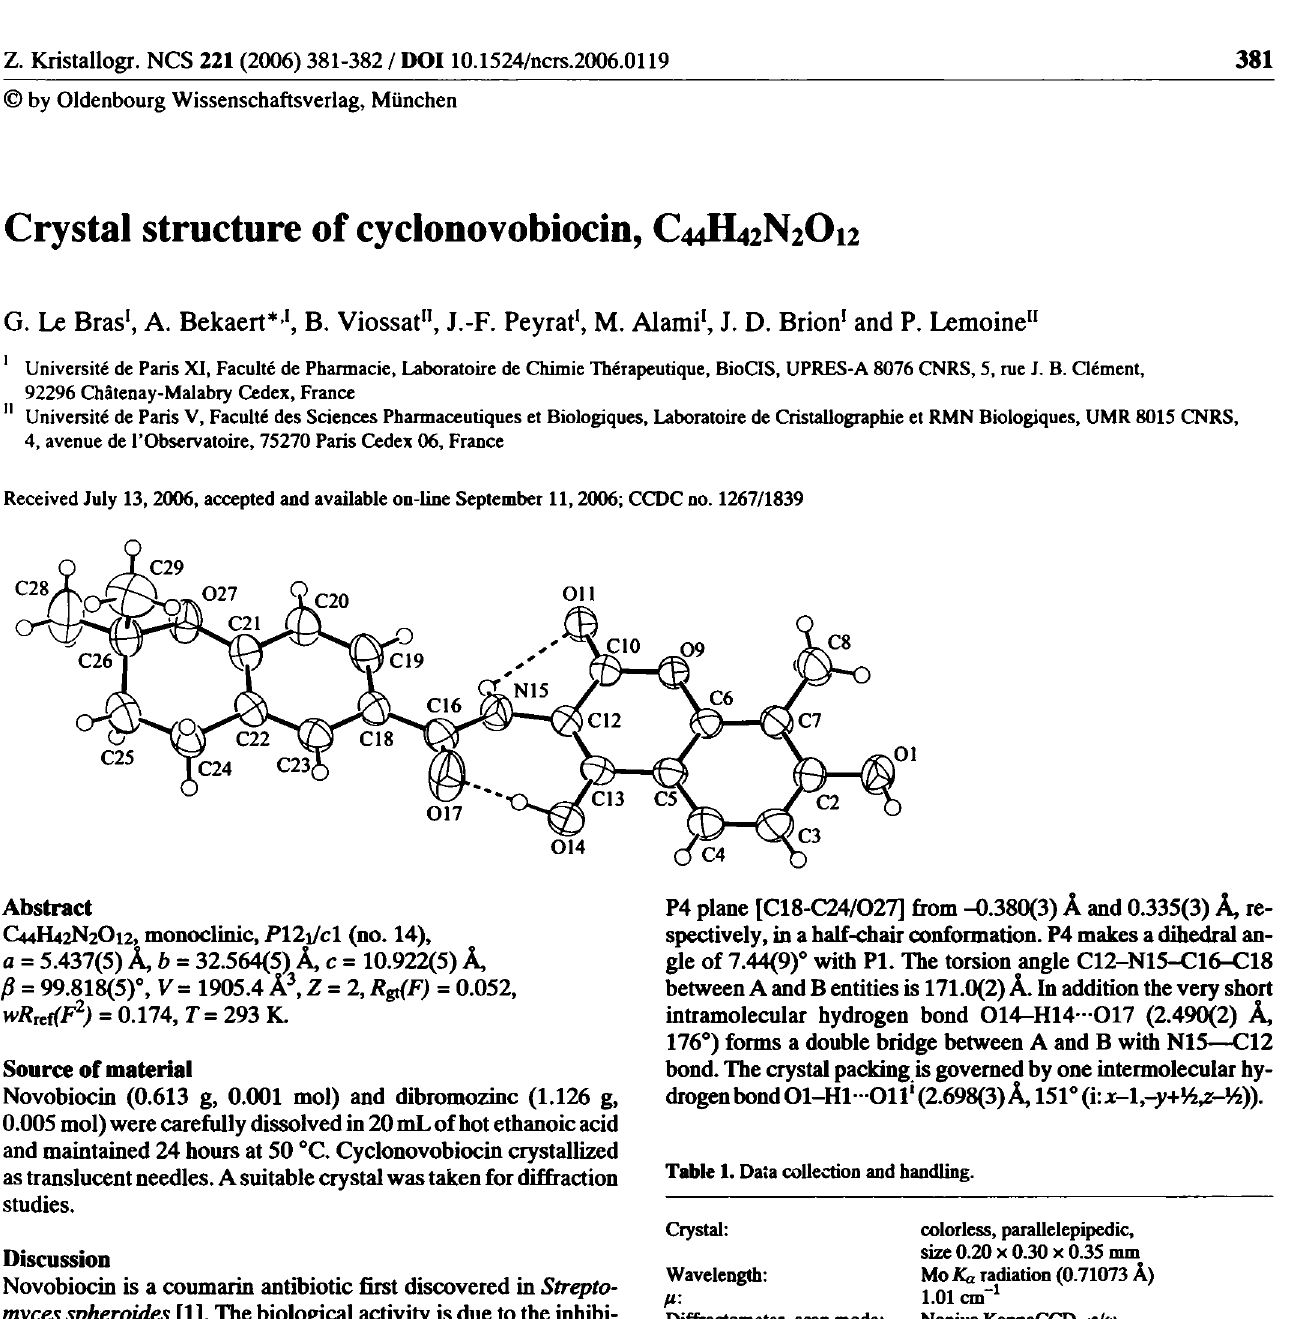
Table 1. Data collection and handling.